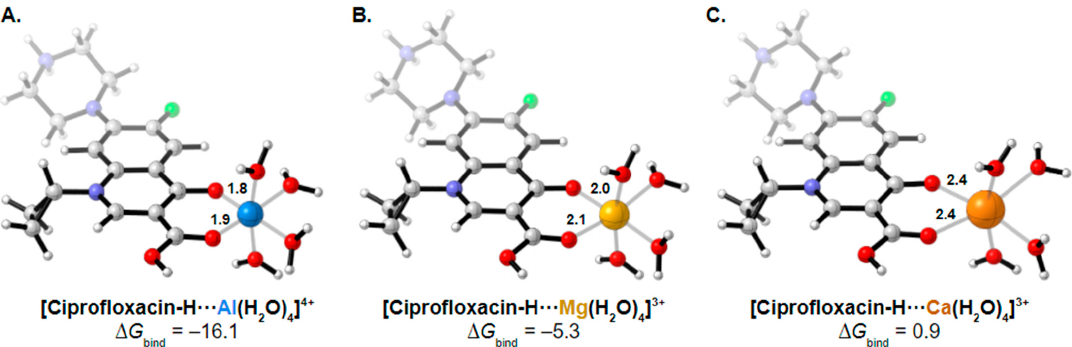
Figure 2. Computed structures and predicted free energies of binding ( ∆ G bind ) between N -protonated cationic ciprofloxacin and ( A ) aluminum hydrate, ( B ) magnesium hydrate, and ( C ) calcium hydrate. Structural images generated using CYL-View [70] .